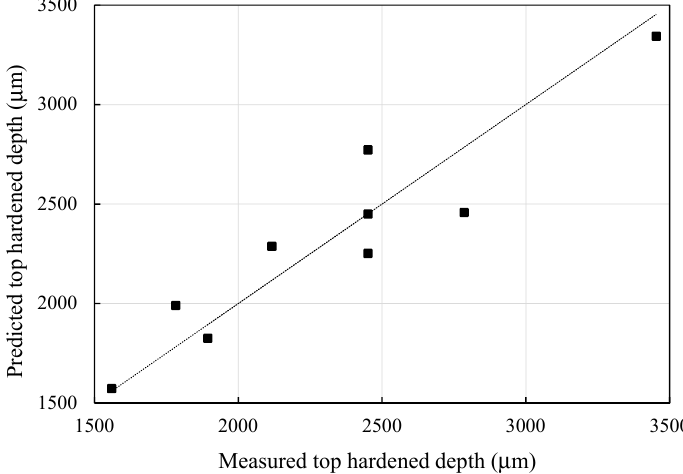
Figure 11. Measured and predicted tooth top hardened depth.